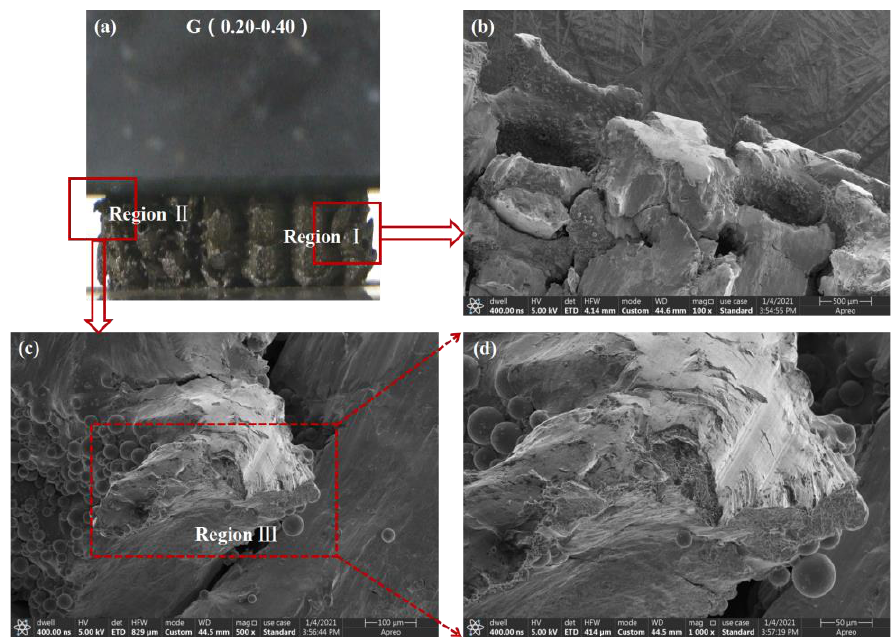
Figure 10. FEM results of maximum principal stress distribution on the surface of lattice structures at 0.02 strain under compressive loading: ( a ) U(0.50), ( b ) U(0.20), ( c ) G(0.30 – 0.50) and ( d ) G(0.20 – 0.40).